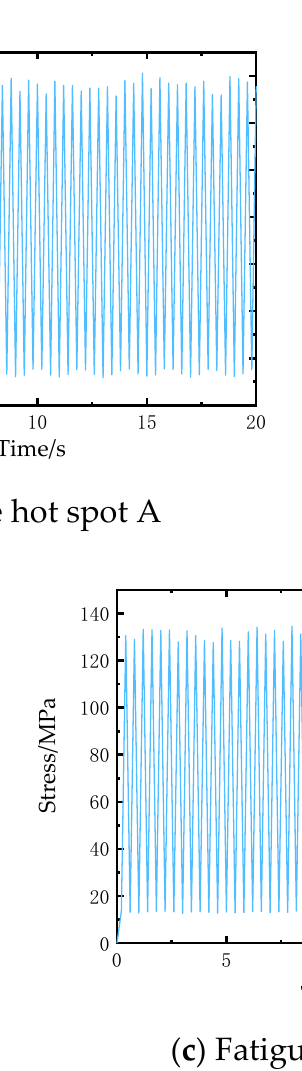
Figure 10. Element stress in X direction at the fatigue hot spots of the macro model.